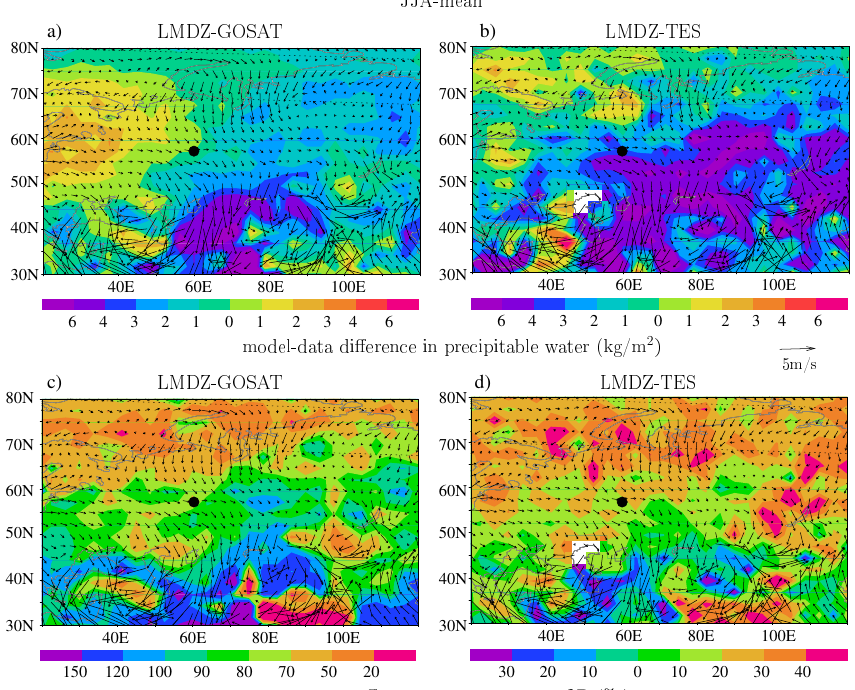
Figure 7. June-July-August (JJA) mean model–data difference for precipitable water (a–b) and total-column water vapor δD (c–d) compared to GOSAT (left) and TES (right). LMDZ outputs are collocated with each data set and averaging kernels are applied to compare with satellite data sets. The black dot indicates the location of Kourovka. Superimposed are the simulated surface winds. They are the same for all figures. the underestimation of the δD seasonal cycle is due to